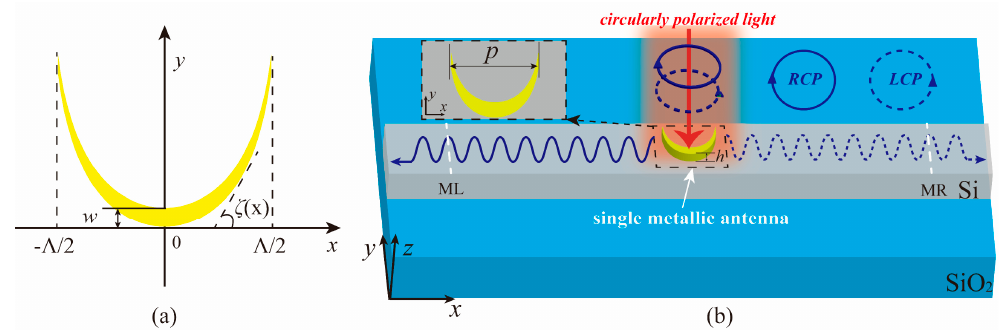
Figure 1. ( a ) Catenary of equal strength in a rectangular coordinate system. ( b ) The schematic of the directional coupler is composed of a single metallic catenary antenna placed on a silicon-on-insulator (SOI) waveguide. The white dotted lines indicate two power monitor ML and MR, and the monitors are 10 μ m away from the antenna.